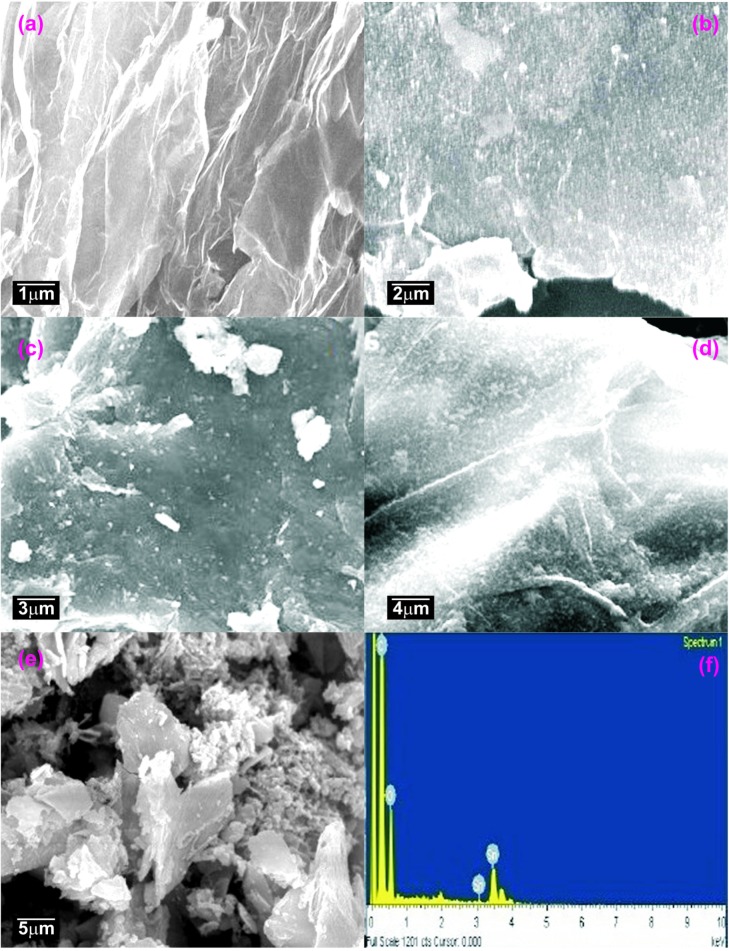
FE-SEM images of (a—e) SnO2/G nanocomposite and (f) EDX spectrum of SnO2/G nanocomposite.